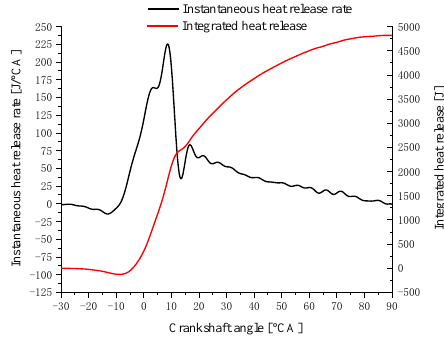
Figure 20. Heat release rate in the two-stroke mode at 2500 rpm, 92 kW.